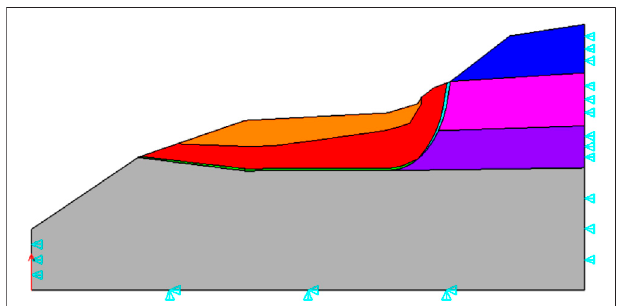
FIGURE 7 | Calculation model of Xiashan landslide in